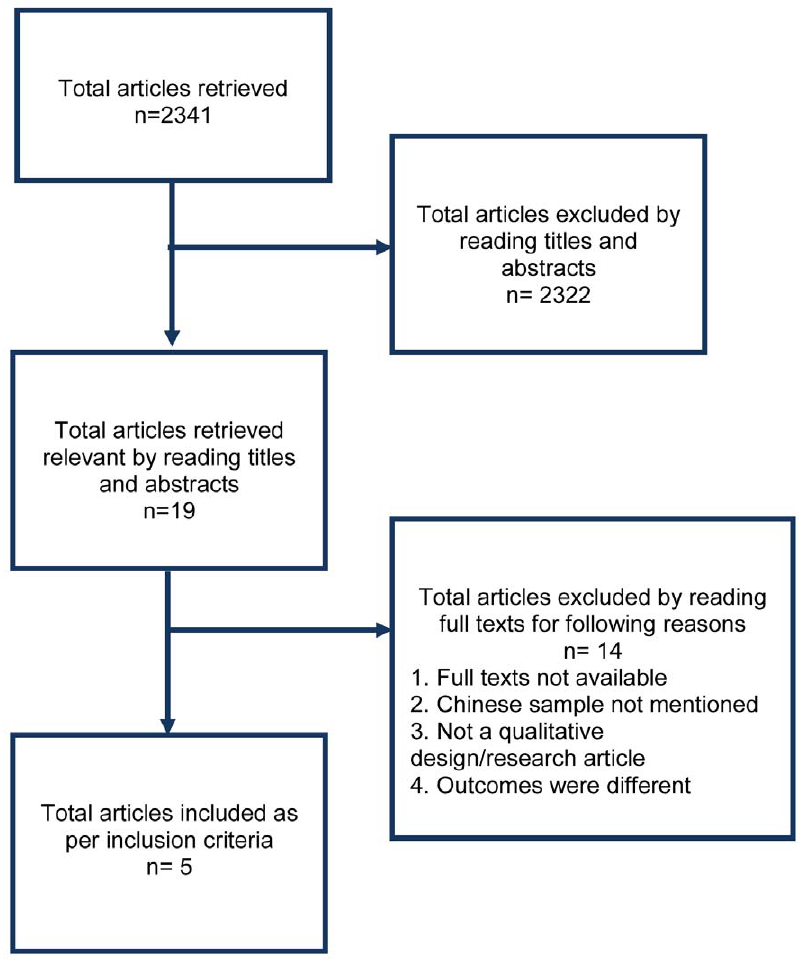
Figure 1. Study plan.